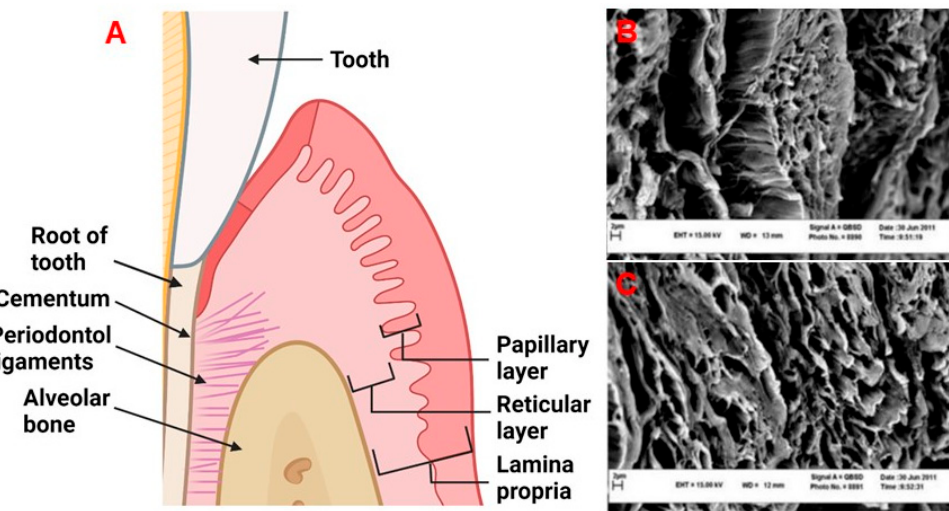
Figure 1. ( A ) The periodontal tissue anatomy. Created with BioRender.com. ( B , C ) Decellularized human gingival tissue adapted from previous literature reproduced under terms of the CC-BY li- cense [16]. Copyright 2012, Nasser Mahdavishahri, Maryam Moghatam Matin, Masoud Fereidoni, Zahra Yarjanli, Seyed Ali Banihashem Rad, and Saeedeh Khajeh Ahmadi, published by Iranian Jour-